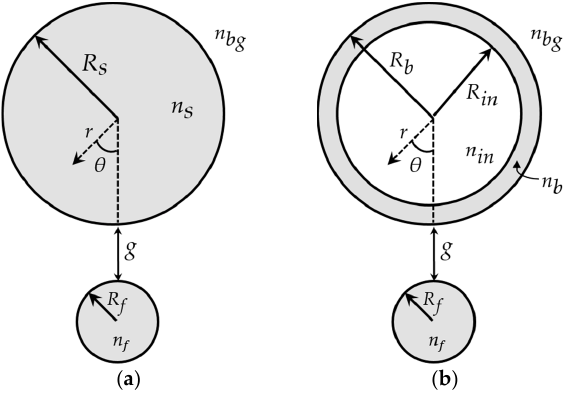
Figure 2. Geometrical configurations of the simulated coupling systems consisting of a tapered fiber coupled to ( a ) a microsphere and ( b ) a microbubble. The cross-section of the tapered fiber waist is shown. The light grey color represents the silica glass.